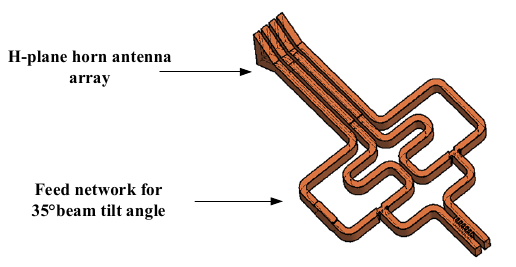
Figure 8. The structure of the whole array antenna integrated with feed network.